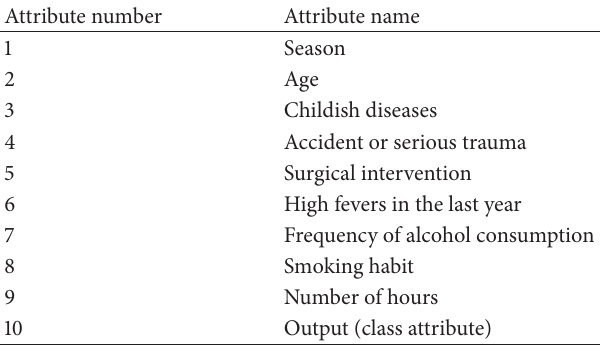
Table 2: Fertility data set attribute information.